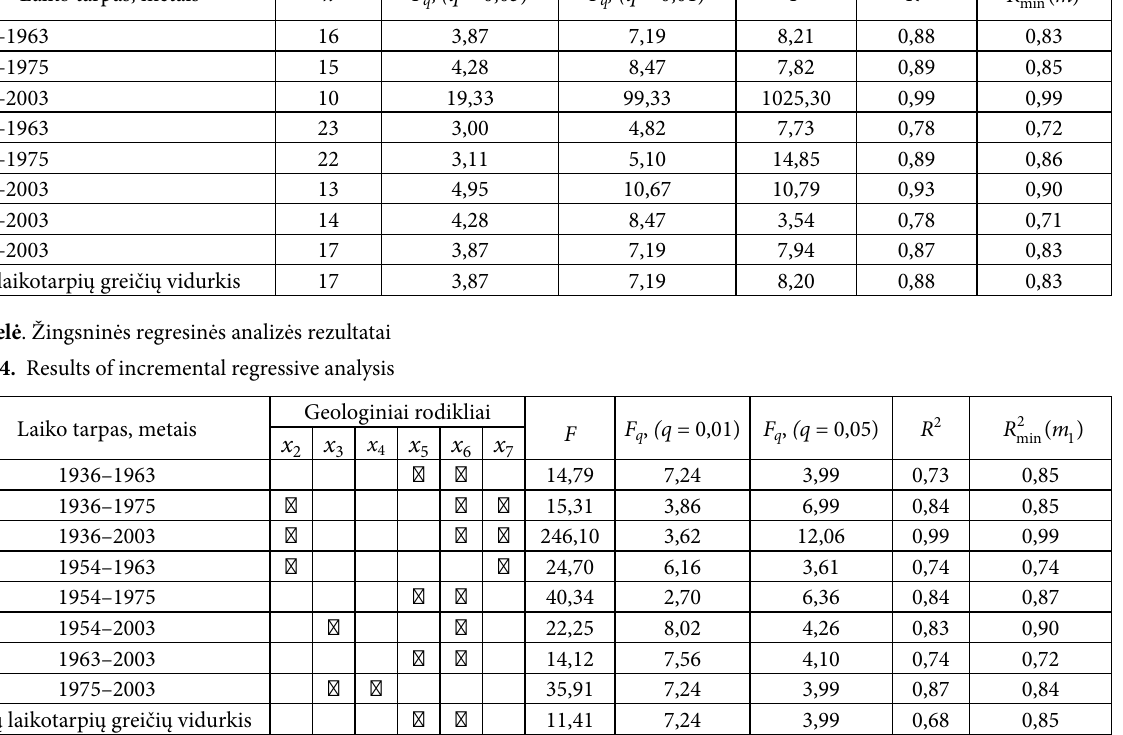
Table 3. Analysis of regressive, equations including all indexes, which characterize territory Laiko tarpas, metais